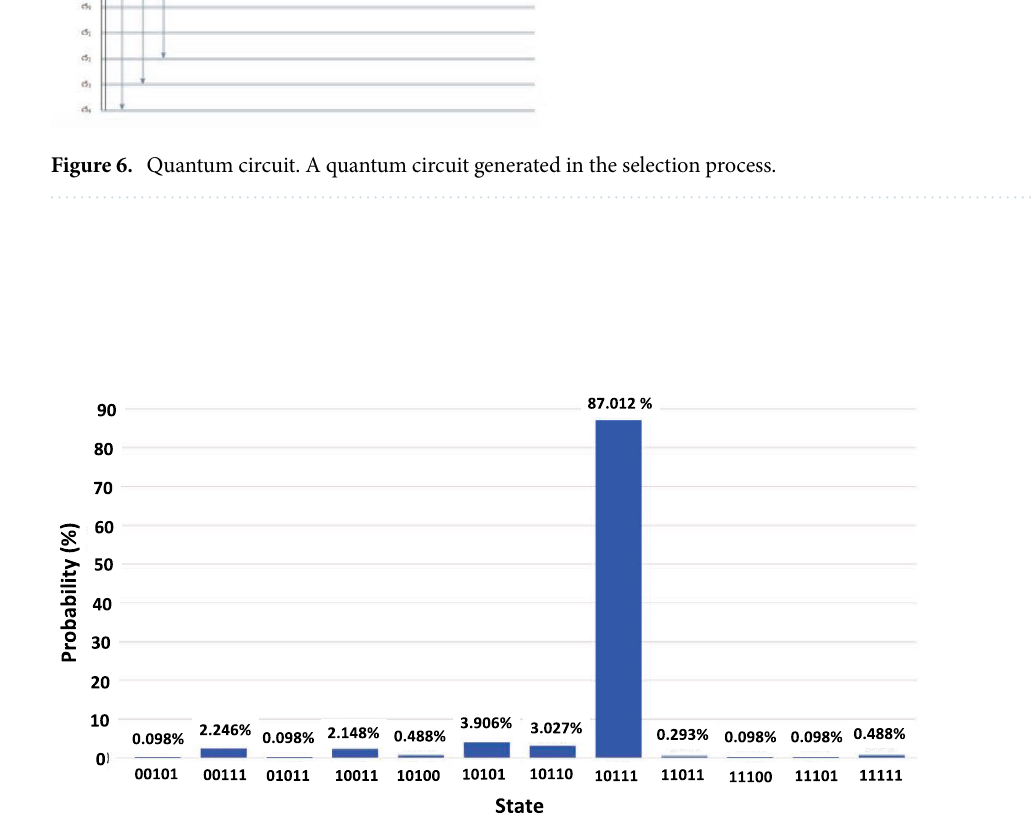
Figure 7. Histogram of final state probabilities after 8192 runs on the quantum computer ibmq_vigo. The correct state was selected with a probability of 87.012%, or 7128 of 8192 runs. The 20 of 32 states not shown in the histogram were states in which the system was not measured on any run. The K–L divergence of this distribution from its corresponding simulation is